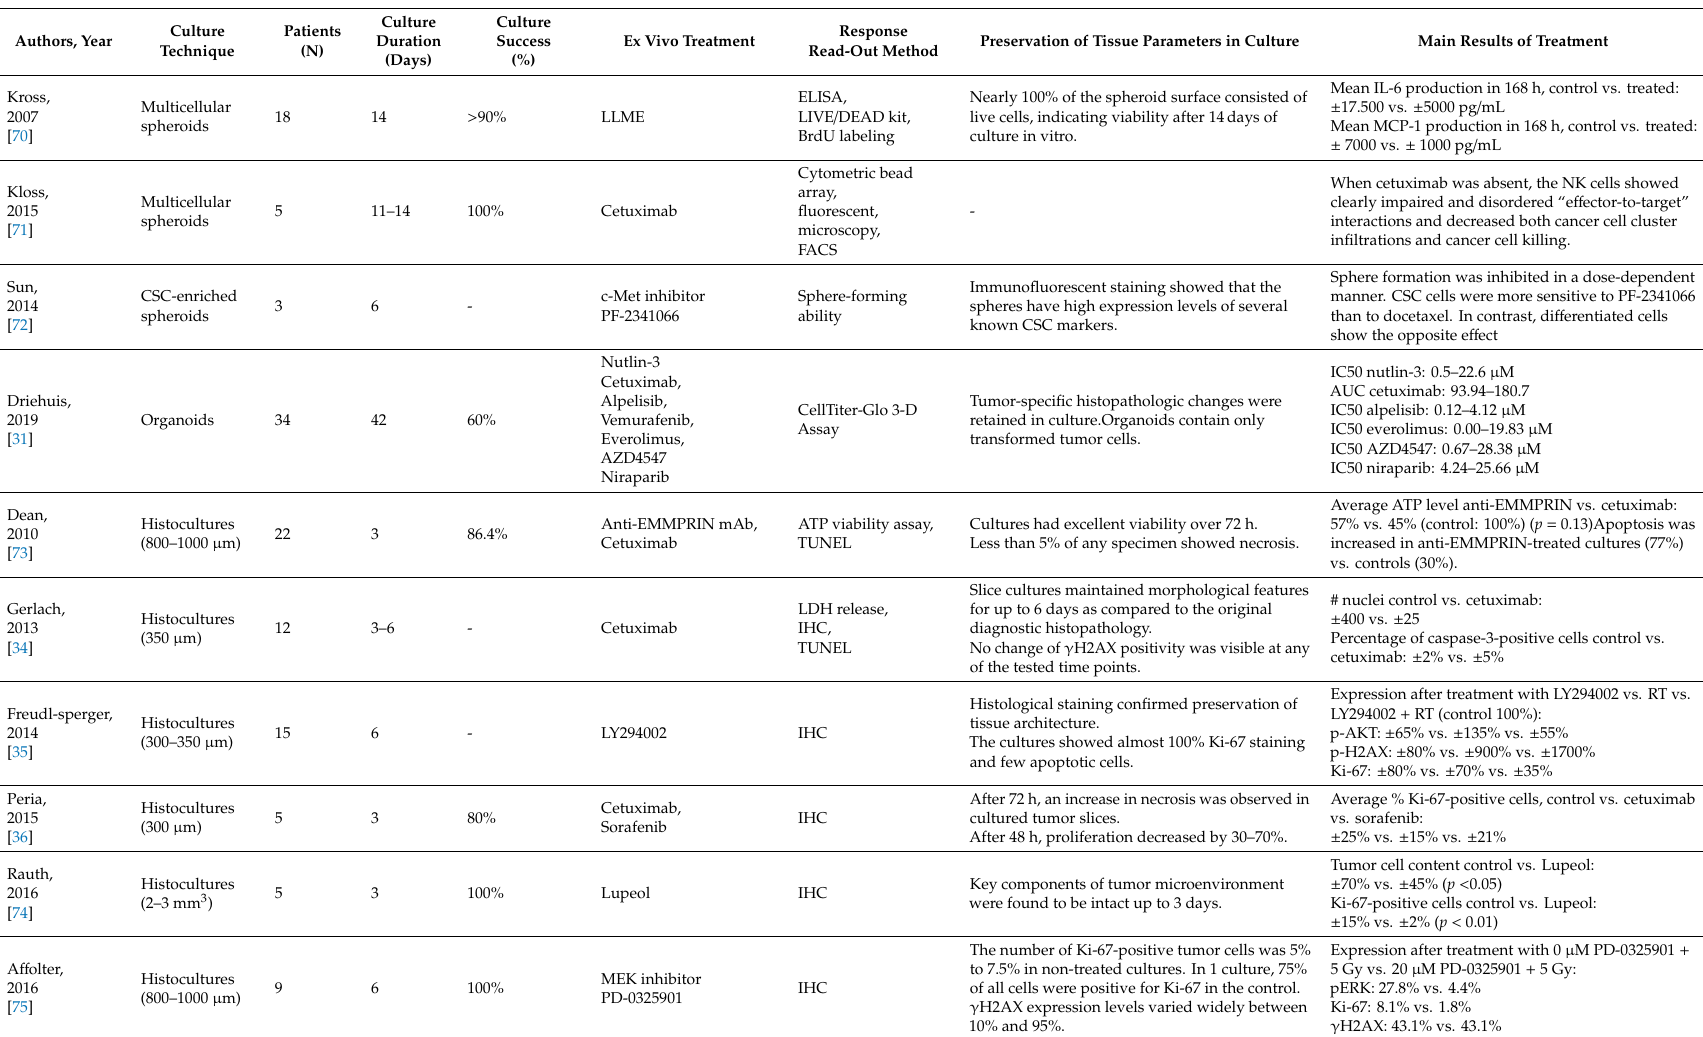
Table 4. Overview of selected studies using immunotherapy or targeted therapy on various cultures from HNSCC tissue.